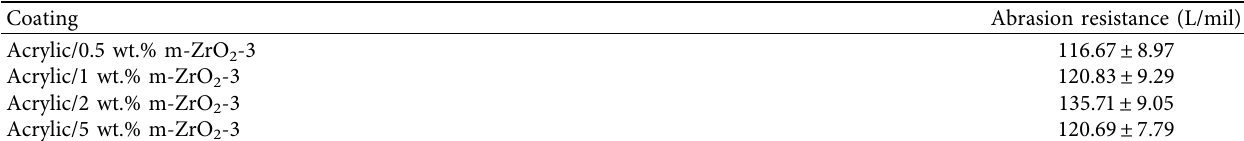
Table 4: Abrasion resistance of coating based on acrylic resin and different contents of m-ZrO